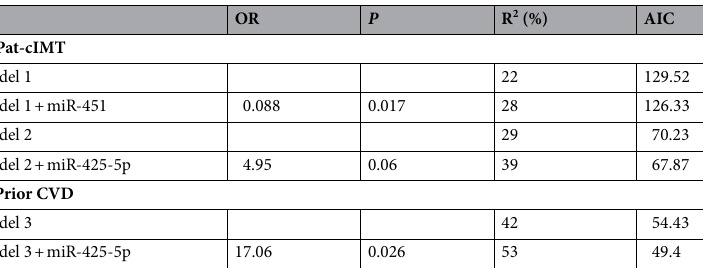
Table 2. Adjusted OR estimates of the effect of miR-425-5p and miR-451 expression on pathological cIMT (A) and on prior CVD (B). Adjusted OR estimates were assessed by logistic regression analysis applied to women (model 1) and to men (model 2 and 3) with or without inclusion of candidate miRs expression. Models were initially adjusted for age, RA disease onset, BMI, ischemic heart disease, peripheral artery disease, ictus, creatinine, and treatments. OR = odds ratio, AIC = Akaike information criteria. p = p value.